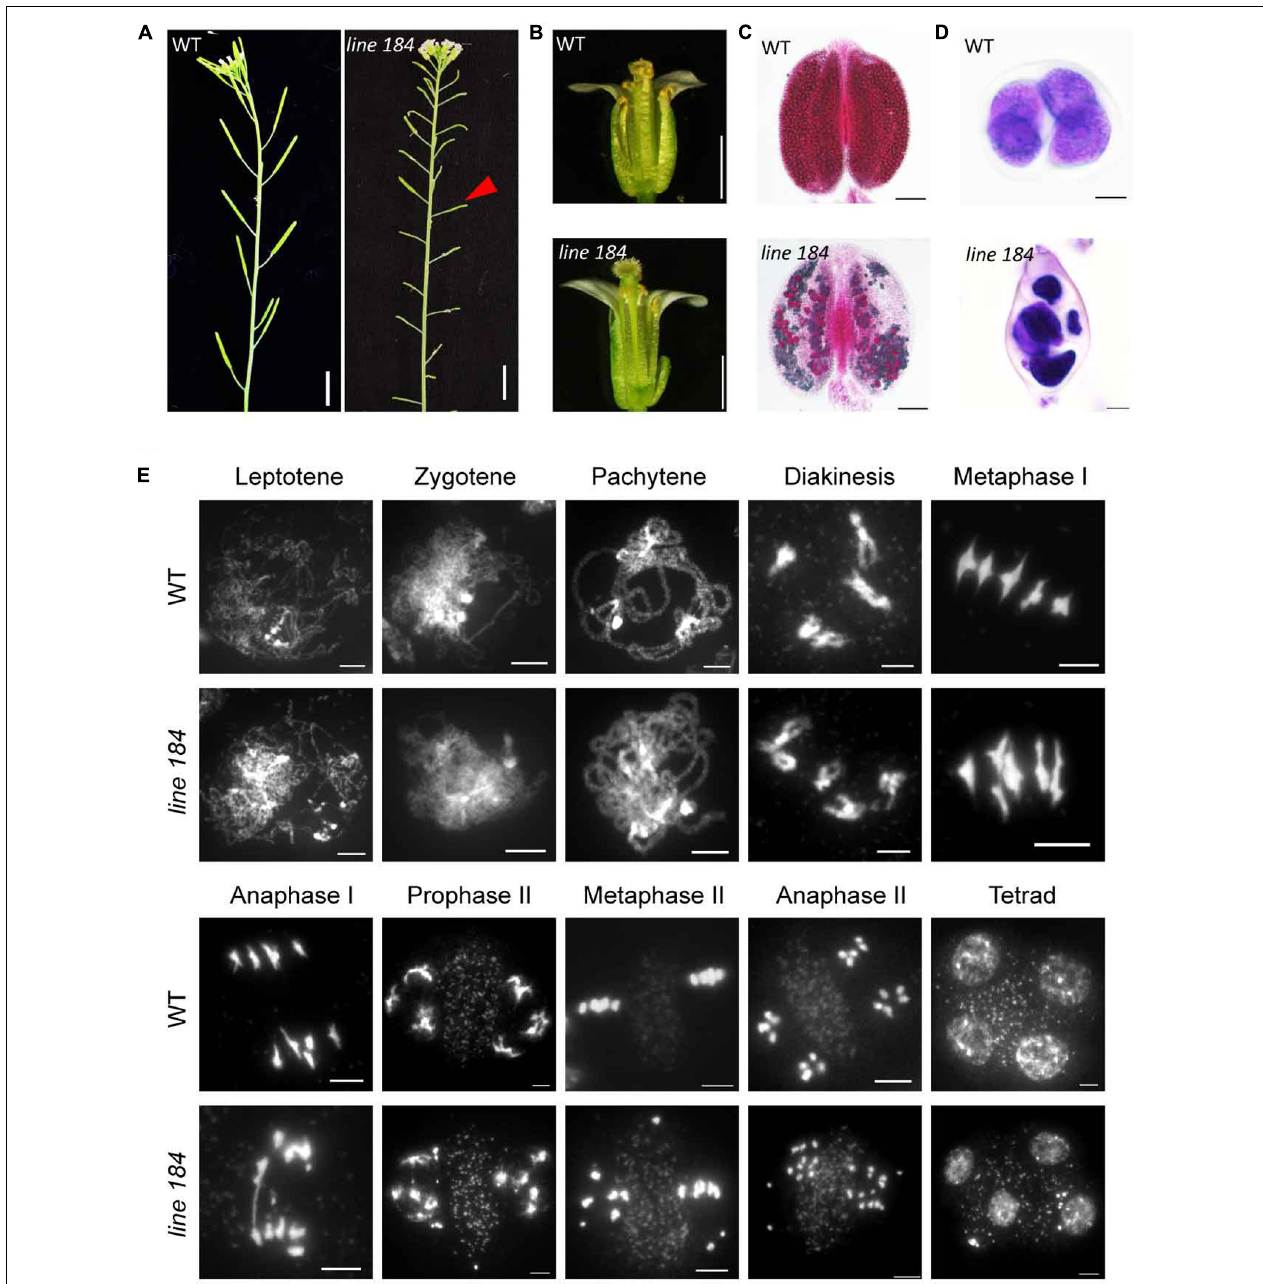
FIGURE 1 | Phenotypic analysis of a mutant allele with fertility defects. (A) Plant fertility phenotype of wild type (L er ) and line 184 mutant. Red arrow indicates short silique of the mutant. Bar = 1 cm. (B) Morphology of open flower of wild type (L er ) and line 184 mutant. The mutant has shorter filaments and nearly no pollen grains could be observed on the stigma. (C) Pollen viability (Alexander staining) in wild type and line 184 mutant anthers. Bar = 100 µ m. (D) Morphology of microspore tetrad (stained with toluidine blue). Normal meiosis produce tetrad contains four microspores whereas the mutant produce polyads contain more than four microspores. Bar = 10 µ m. (E) Chromosome morphology of male meiosis in wild type and line 184 . Bar = 5 µ